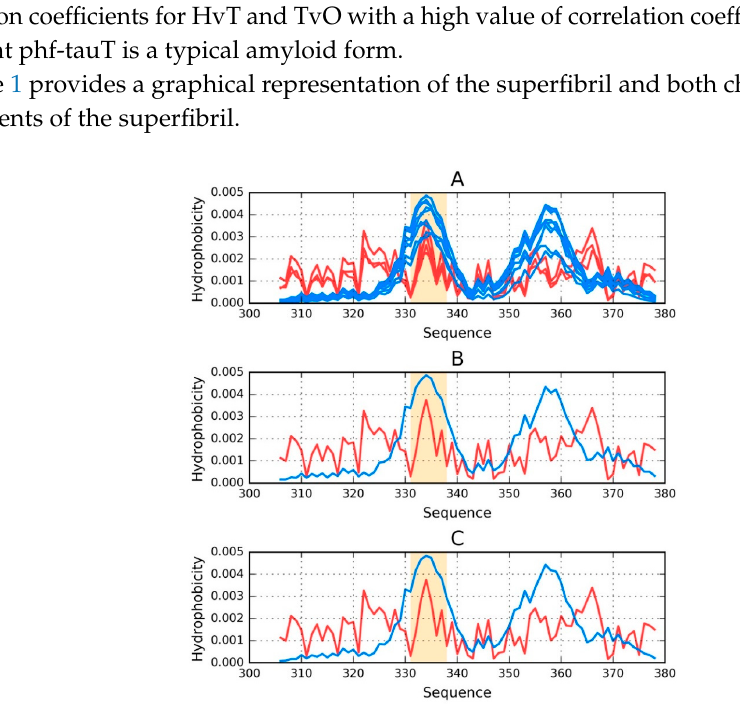
Chain Table 2. Status of individual chains treated as components of the superfibril. The presentation of phf-tauL is omitted since due to its similarity to phf-tauO. Chain